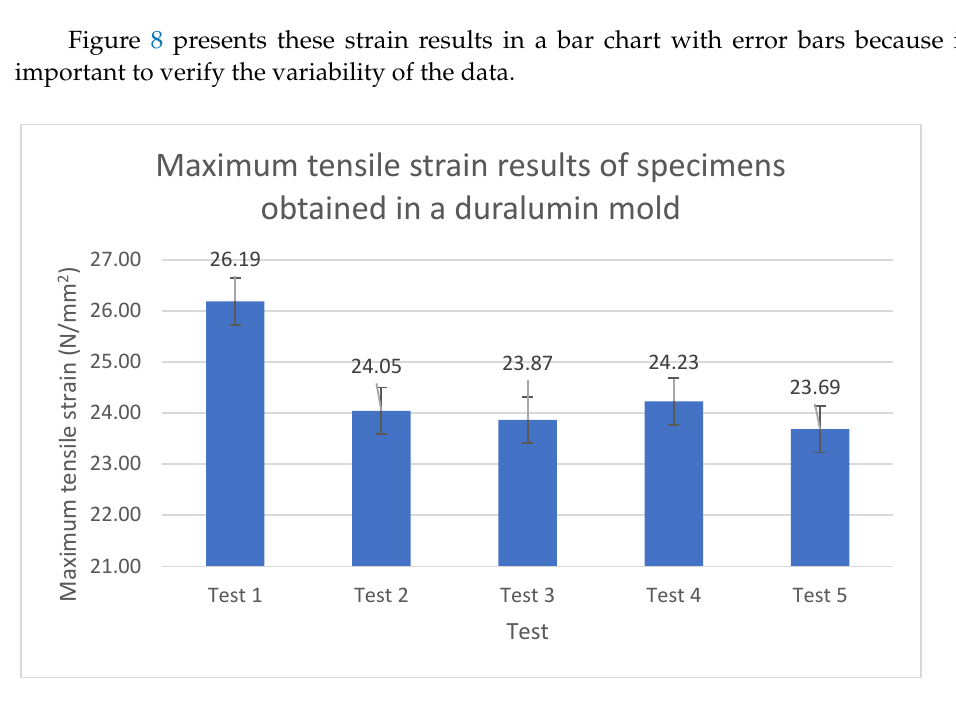
Figure 8. Maximum tensile strain of the specimens obtained in a duralumin mold.